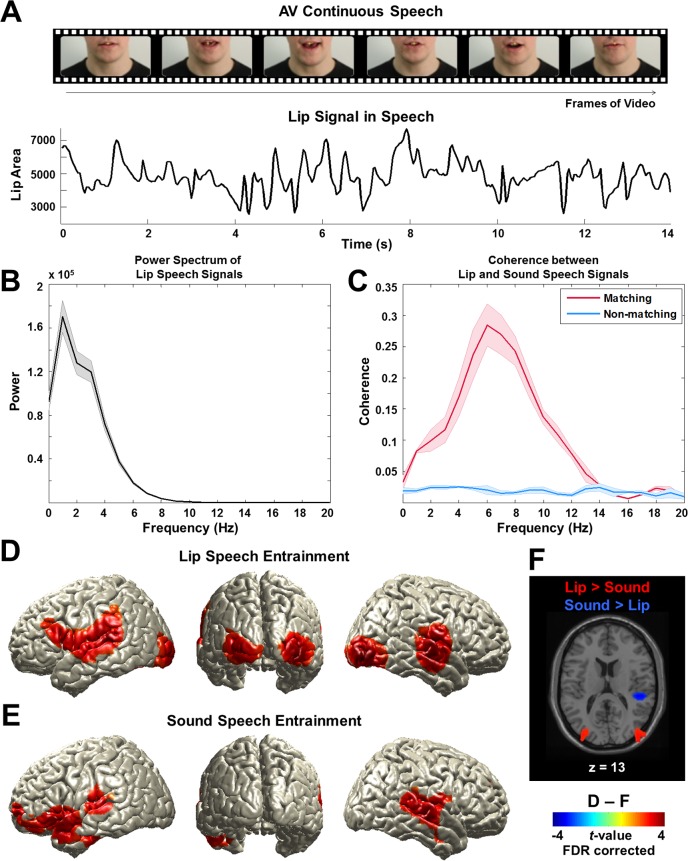
Lip signals in continuous speech and its entrainment in the brain.(A) Lip signals in the continuous audiovisual speech.Lip contour was extracted for each video frame and corresponding area was computed (see Figure 2—figure supplement 1A,B,C for details). One representative lip speech signal (for around 14 s speech) is shown here. Speaker’s face is cropped for this publication only but not in the original stimuli. (B) Spectral profile of lip speech signals. The power spectra of lip speech signals used in this study were averaged (mean ± s.e.m.). Signal is dominated by low-frequency components from 0 to 7 Hz that robustly peak around 0 to 4 Hz corresponding to delta and theta band neuronal oscillations in the brain. (C) Coupling between lip and sound speech signals by coherence. Coherence between matching (red line) and non-matching (blue line) lip and sound speech signals were computed and averaged across talks used in the study (mean ± s.e.m.). (D) Lip speech entrainment in natural audiovisual speech (All congruent condition). Coherence was computed between lip speech signal and brain activity at each voxel and then statistically compared to surrogate data at 1 Hz (the dominant frequency in the power spectrum in (b); p<0.05, FDR corrected). (E) Sound speech entrainment in natural audiovisual speech (All congruent condition). Using sound speech envelope, the same computation described in (D) was performed to investigate sound speech entrainment effect (p<0.05, FDR corrected). (F) Lip speech- and sound speech-specific entrainment effects. Lip speech (D) and sound speech coherence (E) were statistically compared (p<0.05, FDR corrected).